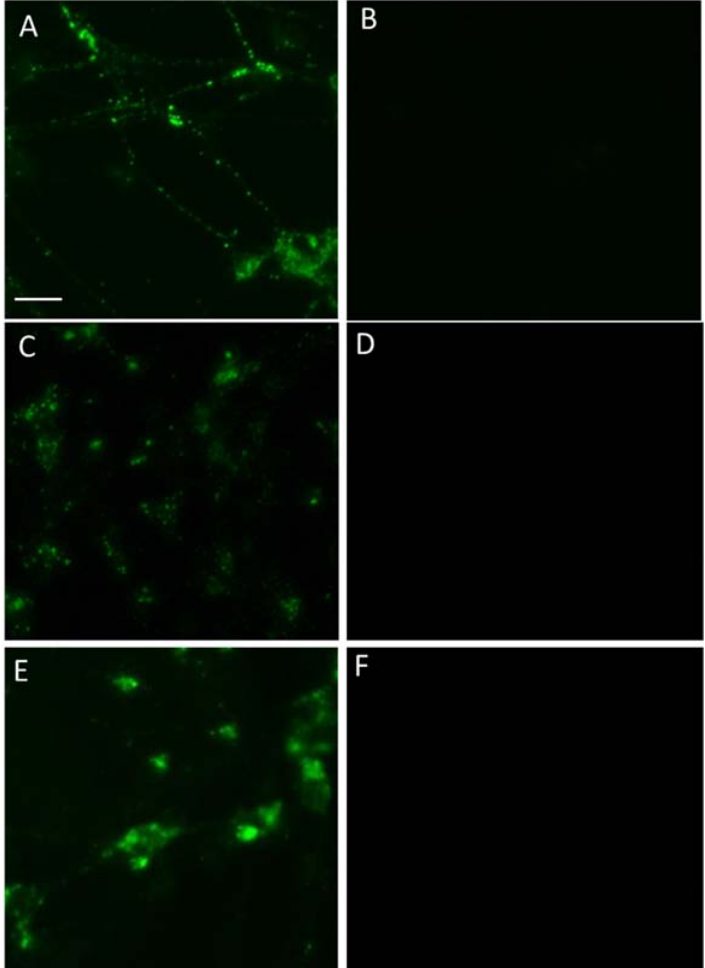
Figure 6. Mouse mesencephalon ( A , B ) and metencephalon ( C , D ) primary cultures and LUHMES cells ( E , F ) after incubation with GBR-BP (50 nM, 60 min) ( A , C , E ) or after pre-incubation with GBR-12909 (10 µ M, 15 min) and subsequent co-incubation (60 min) with GBR-BP (50 nM) and GBR-12909 (10 µ M) ( B , D , F ). Objective magnification = × 20. Selective fluorescent staining with GBR-BP is prevented by GBR-12909, a monoamine transporter inhibitor. Bar = 25 µ m for all photos. Incubation of mouse mesencephalic cells with GBR-ATTO for 60 min at 37 ◦ C re- sulted in uniform staining of individual cells and their conglomerates, which have little resemblance to neurons. After pre-incubation of mesencephalic cells with GBR-12909 and subsequent incubation with GBR-ATTO and GBR-12909 at 37 ◦ C, the cells